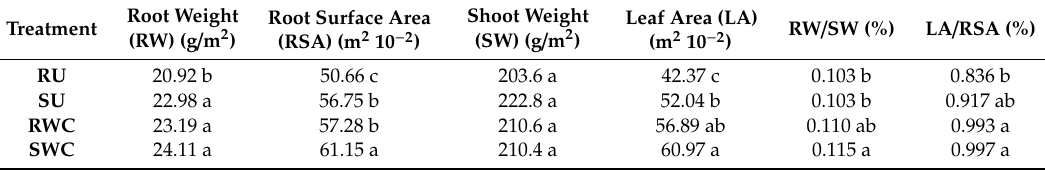
Table 2. Maize shoot and root dry matter, leaf area, root surface area, shoot to root ratio, and the ratio of leaf area to root surface area at blister stage (R2) under the di ff erent cultivation modes in 2014.